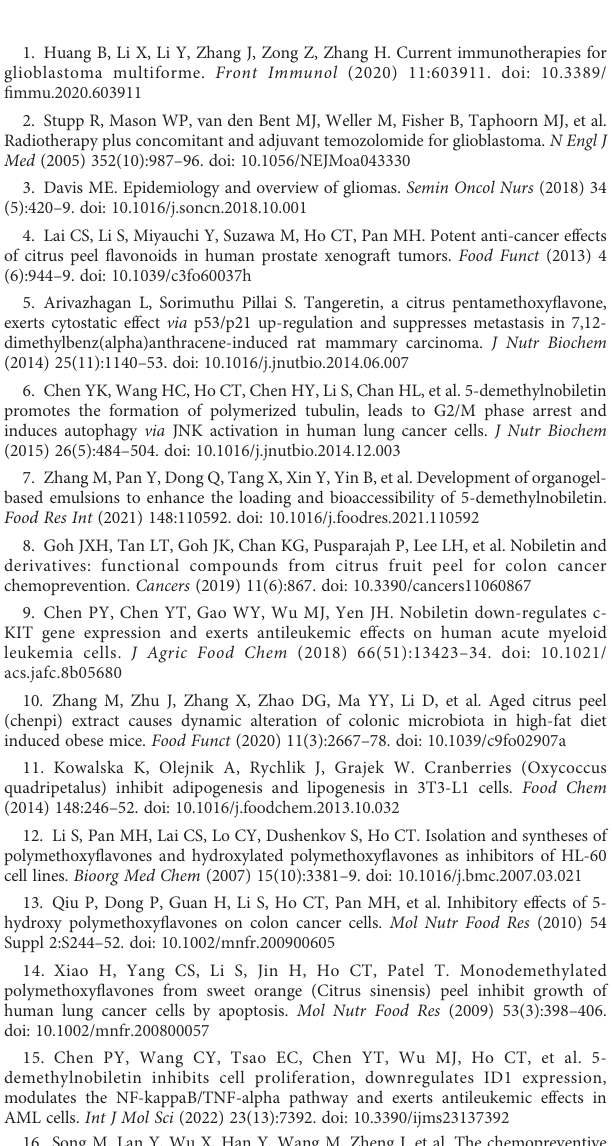
SUPPLEMENTARY FIGURE 1 The inhibitory effect of 5-DMN on normal cells viability and TMZ on GBM cells. (A) Cell viability of normal human brain astrocyte HA1800 and HEK293T cells after being treated with different concentrations of 5-DMN for 48 h. (B) Cell viability was determined using the MTT assay after cultured U87-MG, A172, and U251 cells were incubated with various doses (0, 6.25, 12.5, 25, 50, 100 m M) of TMZ for 48 h. (C) Wound healing assays were used to determine the migration ability of GBM cells after 48 h of incubation with TMZ (0, 25, 50 m M). Values are the means ± SD of three independent experiments. *p<0.05, **p<0.01, ***p<0.001 vs. cells in the untreated control